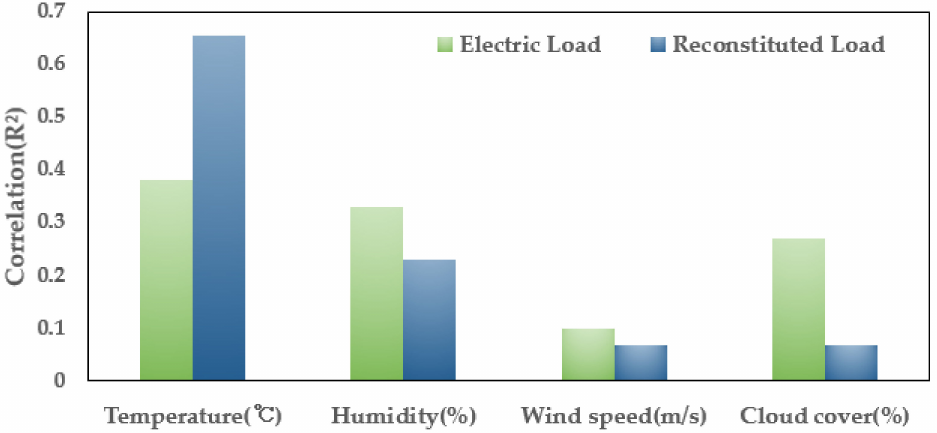
Figure 11. The correlation between electric load, reconstituted load and weather factors in